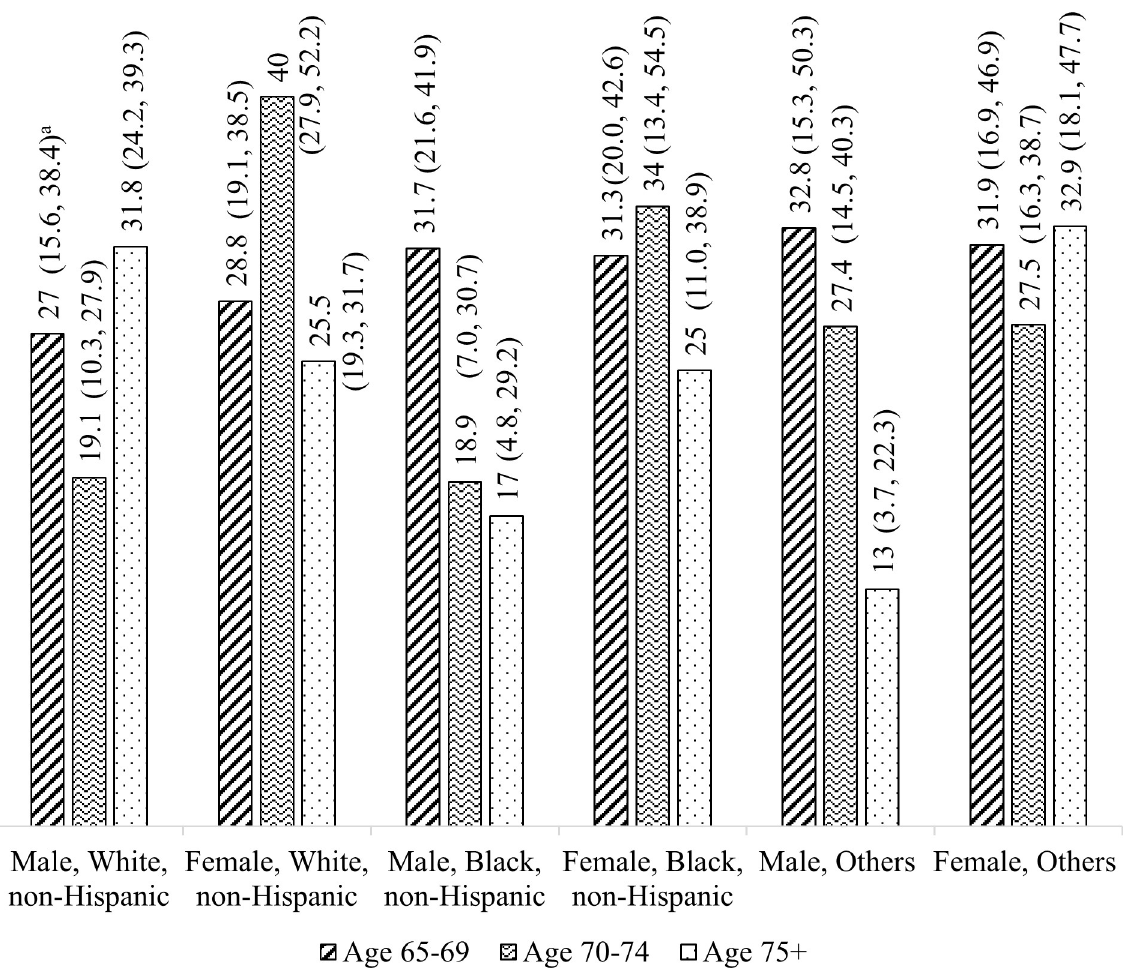
Fig 1. Estimated proportions of prediabetes among older adults by sex, age, and race/ethnicity, 2011–2016 NHANES. Note: We observed that, for some racial or ethnic groups, the prevalence of prediabetes went down with age, which is consistent with Khan and colleagues’ findings [13] and is likely due to people transitioning from prediabetes to diabetes as they get older. a Numbers in parentheses represent 95% Confidence